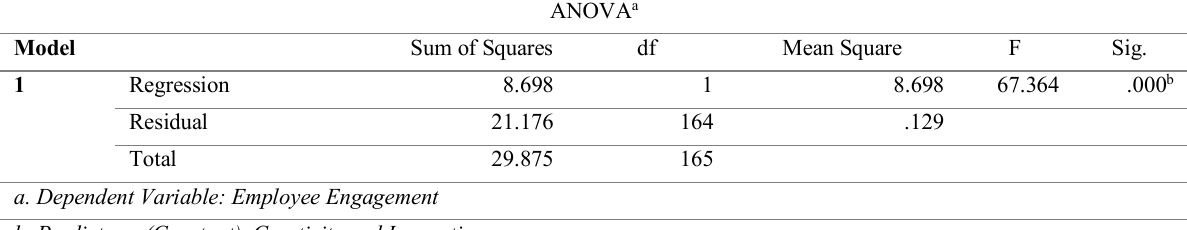
Table 2 (b): Regression ANOVA for creativity and Innovation and Employee